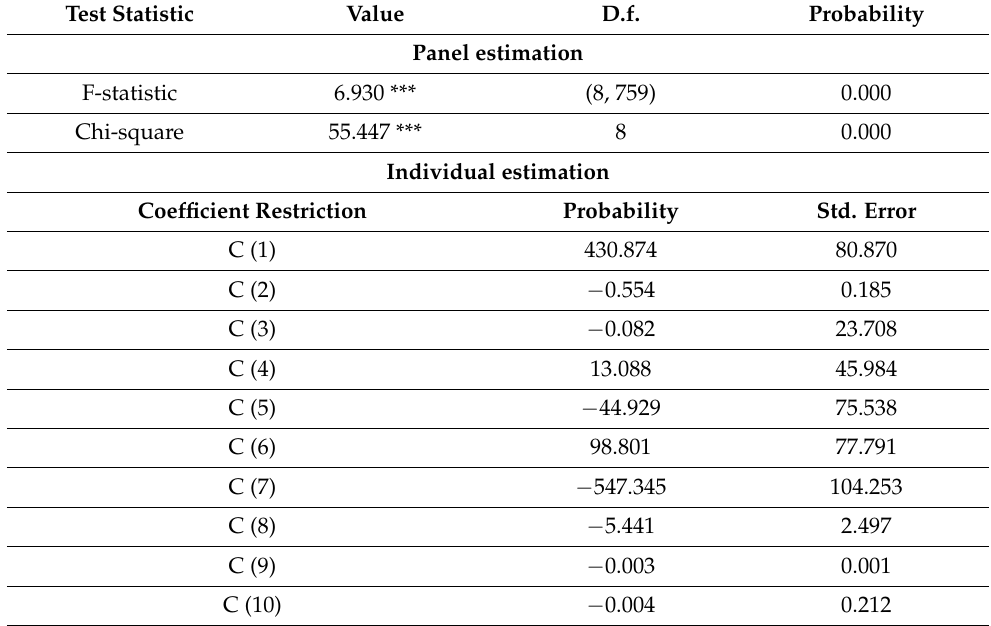
Table A1. Wald Test for Endogeneity.